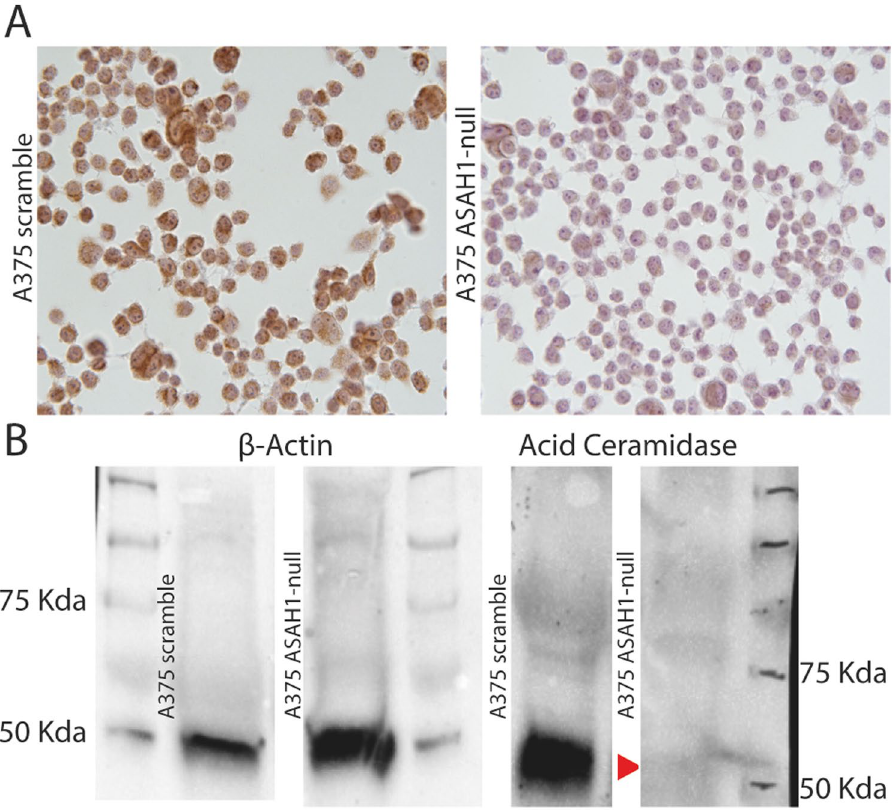
Figure 2. AC deletion in A375 melanoma cells. ( A ) Immunocytochemical analysis showing AC expression in control scramble-treated (left) and ASAH1 -null (right) A375 cells. ( B ) Western blot analyses demonstrate the presence of AC in control scramble-treated but not in ASAH1 -null cells. Arrow indicates AC. ß-actin was used as loading